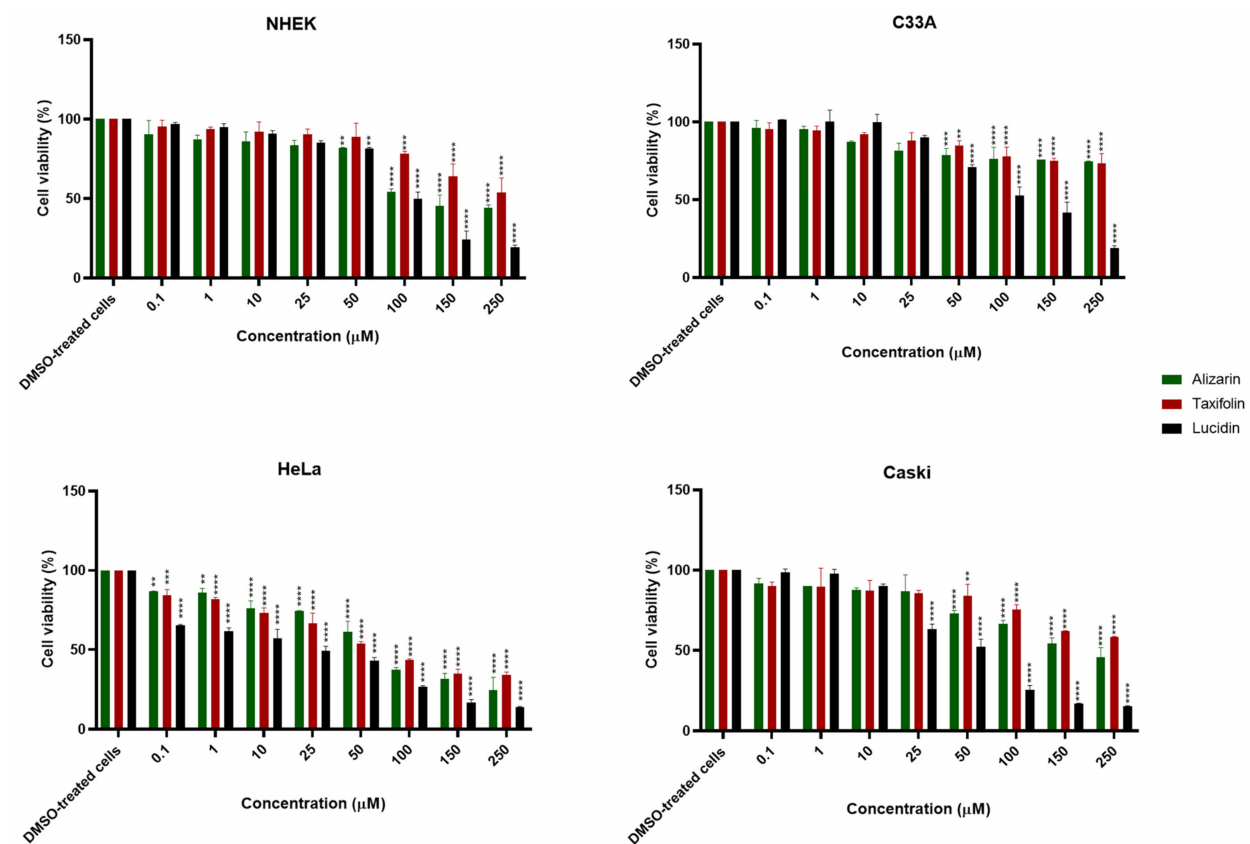
Figure 4. Effect of phenolic compounds on the viability of HPV-positive and negative cell lines. Cells were treated at several concentrations (0.01, 0.1, 1, 10, 50, 100, 150, and 250 µ M) for 48 h, and cell viability was determined by the MTT assay. Data are presented as mean ± SD for three independent experiments ( n = 3) with four technical replicates and analyzed by one-way ANOVA with the Bonferroni test. Significance was determined as p -values ** < 0.01, *** < 0.001, **** < 0.0001. Table 2. Compound concentration required to reduce cell viability by 50% of three independent experiments ( n = 3) determined by regression